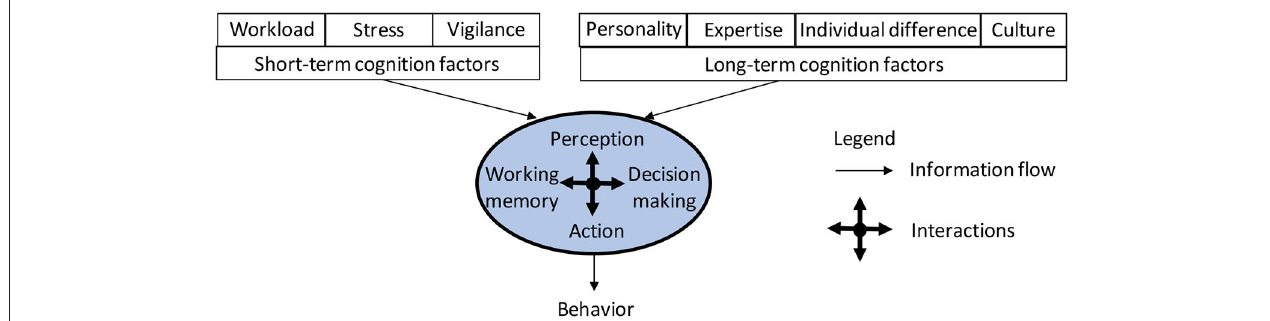
Cognitive psychologists often consider